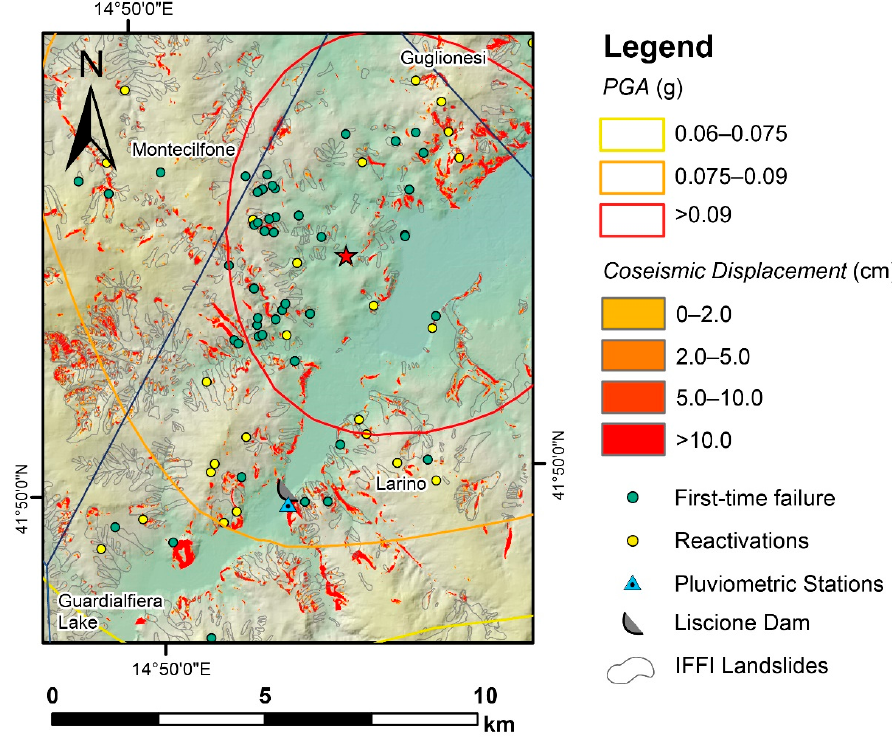
Figure 10. Comparison between the displaced coseismic landslides according to Newmark’s ap- proach and the landslides surveyed after the 16 August 2018